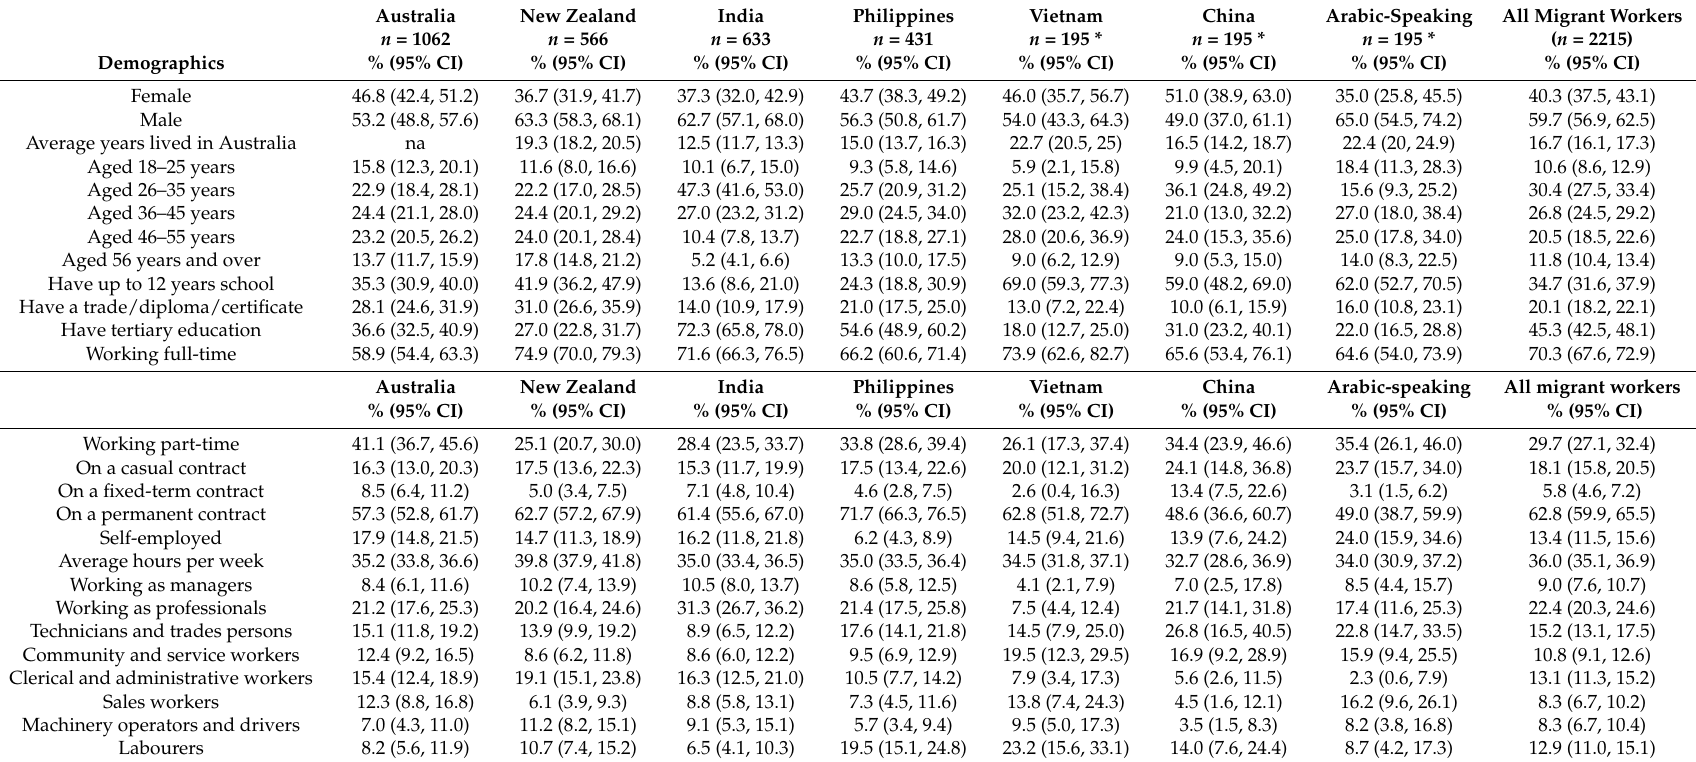
Table 1. Description of participants’ socio demographic and employment characteristics by country of birth, in the Migrant Workers I and II and Australian Worker surveys.